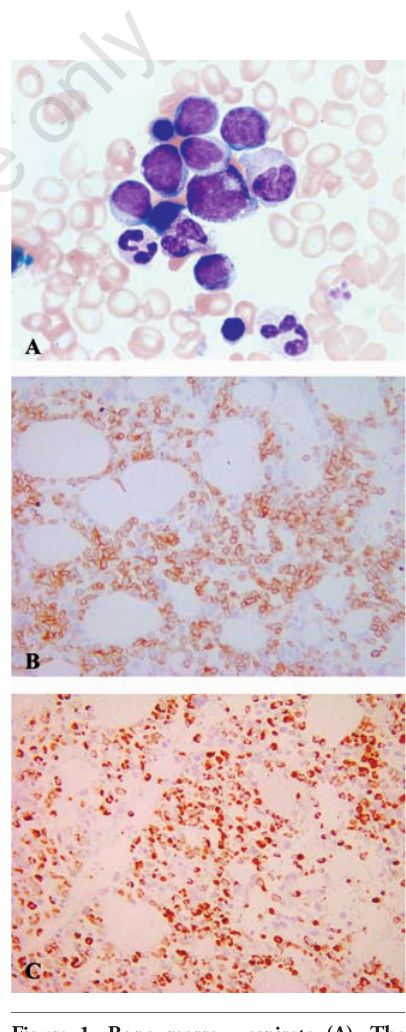
Figure 1. Bone marrow aspirate (A). The blasts have large nuclei with fine chromatin, a single nucleolus, and a moderate amount of light blue cytoplasm (May-Grünwald Giemsa stain, 1000x). Bone marrow biopsy (B, C). Immunohistochemically, tumor cells are CD56 + (B) and show granular cytoplasmic reaction when stained for TIA1 (C)